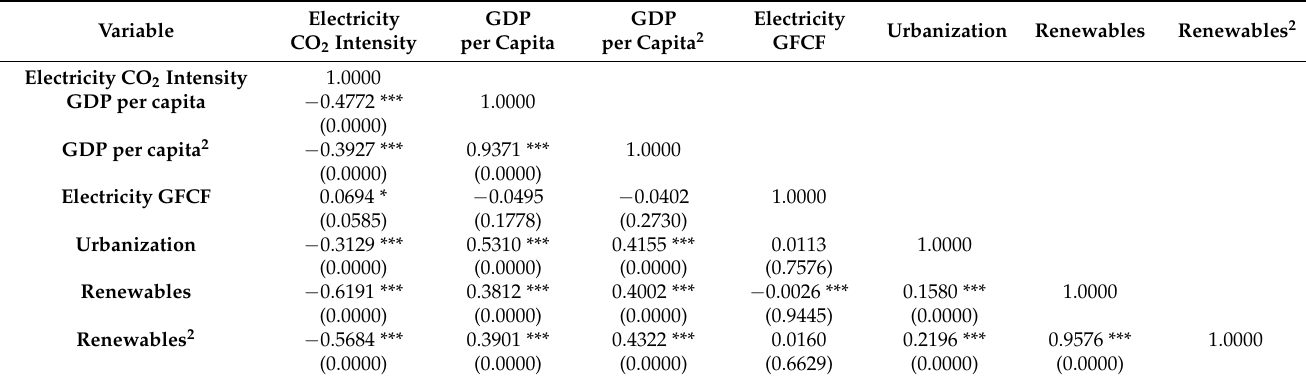
Table 2. Pearson’s correlation